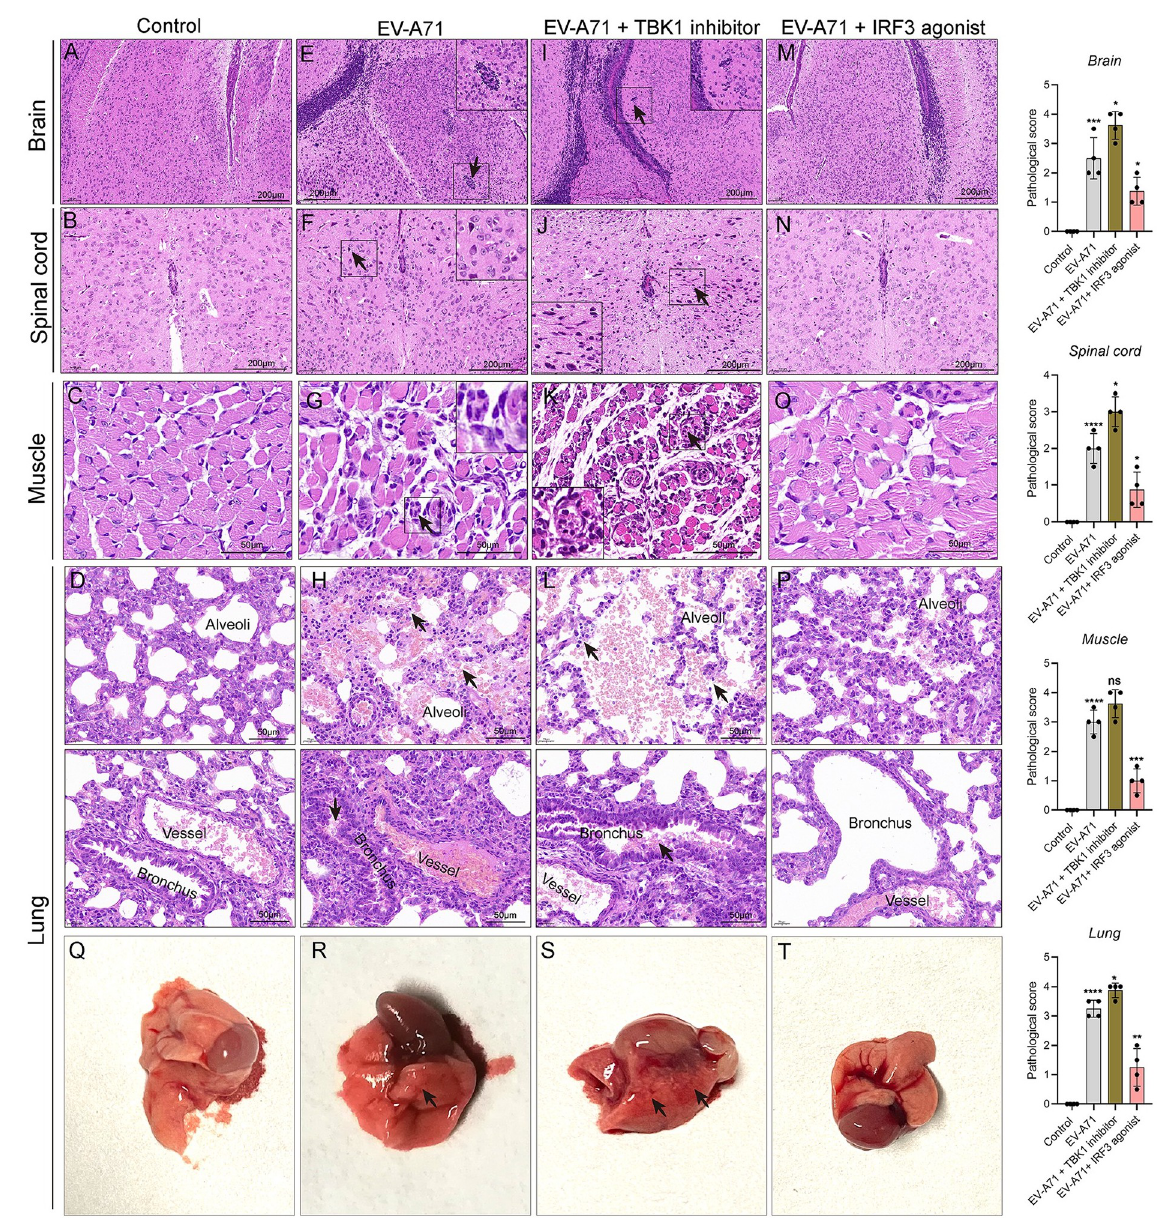
Fig 5. Pathological examination of mouse tissues. Pathological changes in the brains ( A, E, I, M ), spinal cords ( B, F, J, N ), muscles ( C, G, K, O ) and lungs ( D, H, L, P ) of mice at 5 dpi were evaluated by H&E staining. Scoring for each section was evaluated on scale of 0 to 4 with increments of 0.5 independently by three observers for pathological changes. n = 4 per group; EV-A71 vs Control; EV-A71-infected mice with TBK1 and IRF3 interventions vs EV-A71-infected mice; � P < 0.05; �� P < 0.01; ��� P < 0.001; ���� P < 0.0001; ns, not significant. ( Q-T ) Fresh lung tissues dissected from different experimental groups. Black arrows indicate typical pathological lesions. All experiments were repeated three times.